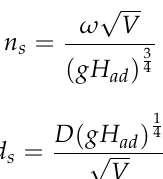
Figure 12. KAIST-OCD Optimization Result for Open-air Brayton Cycle.